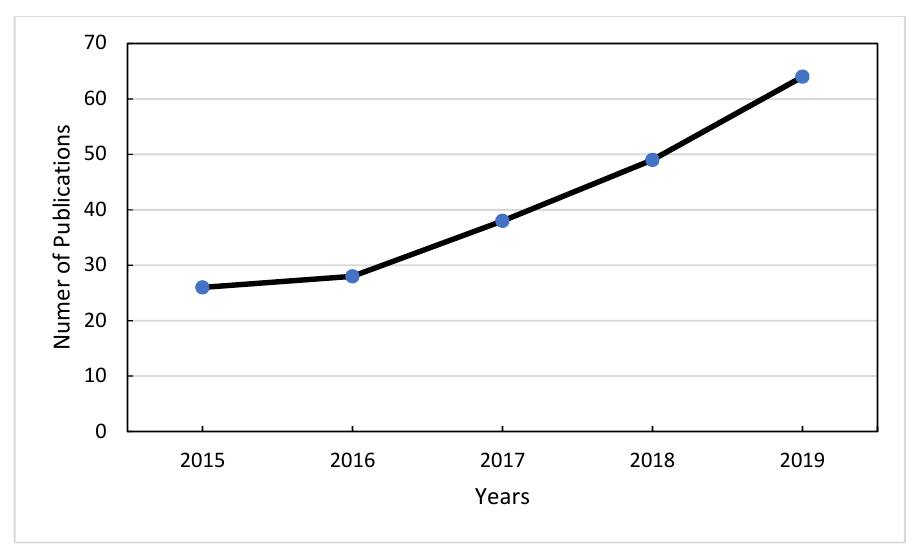
Figure 1. Published research for geographical origin authentication in the last five years.